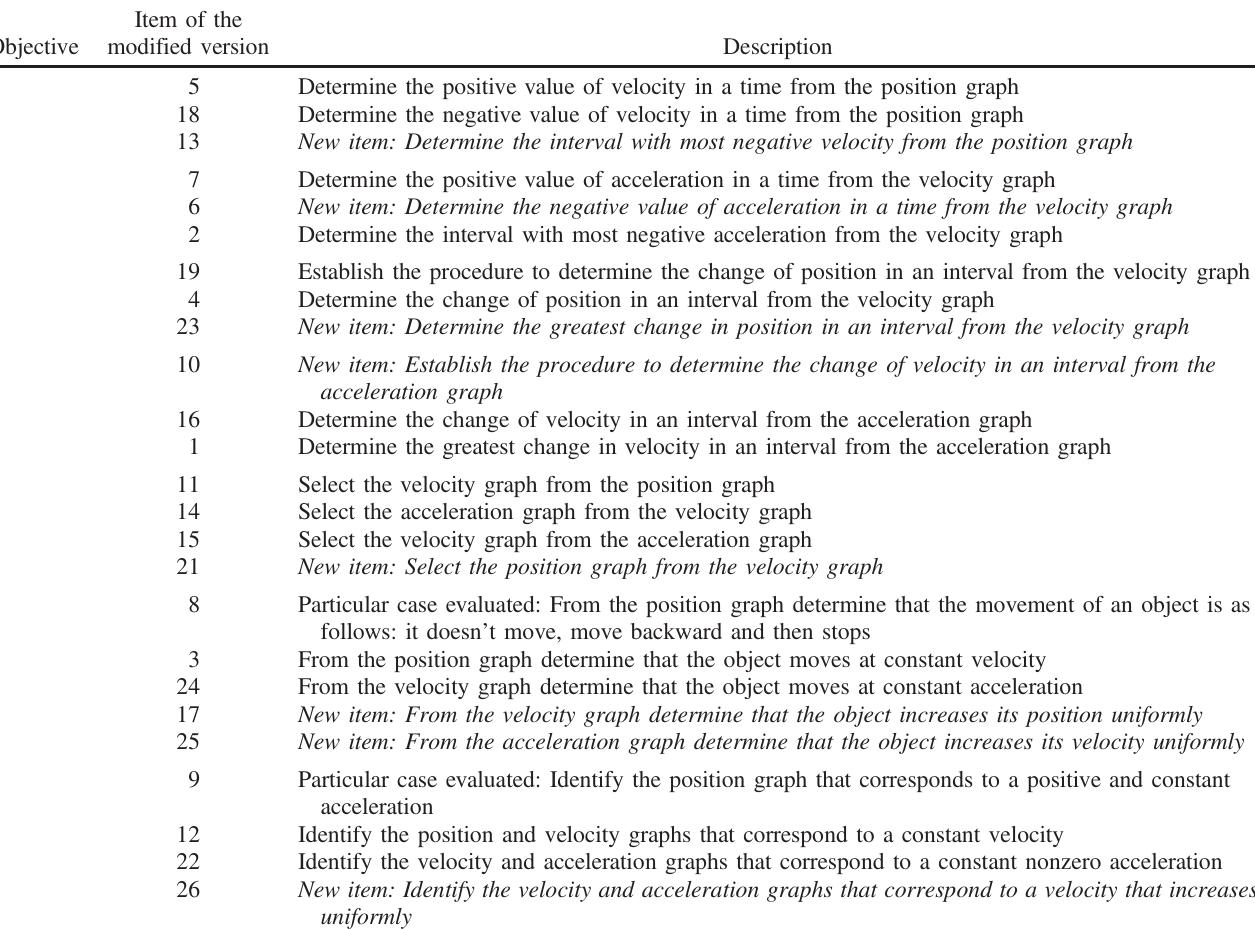
TABLE VI. Description of the items of the modified version grouped in each of the seven objectives. The descriptions in italics correspond to the nine new added